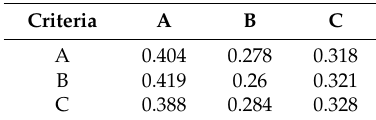
Figure 6. Dimension C–criterion of IRM.